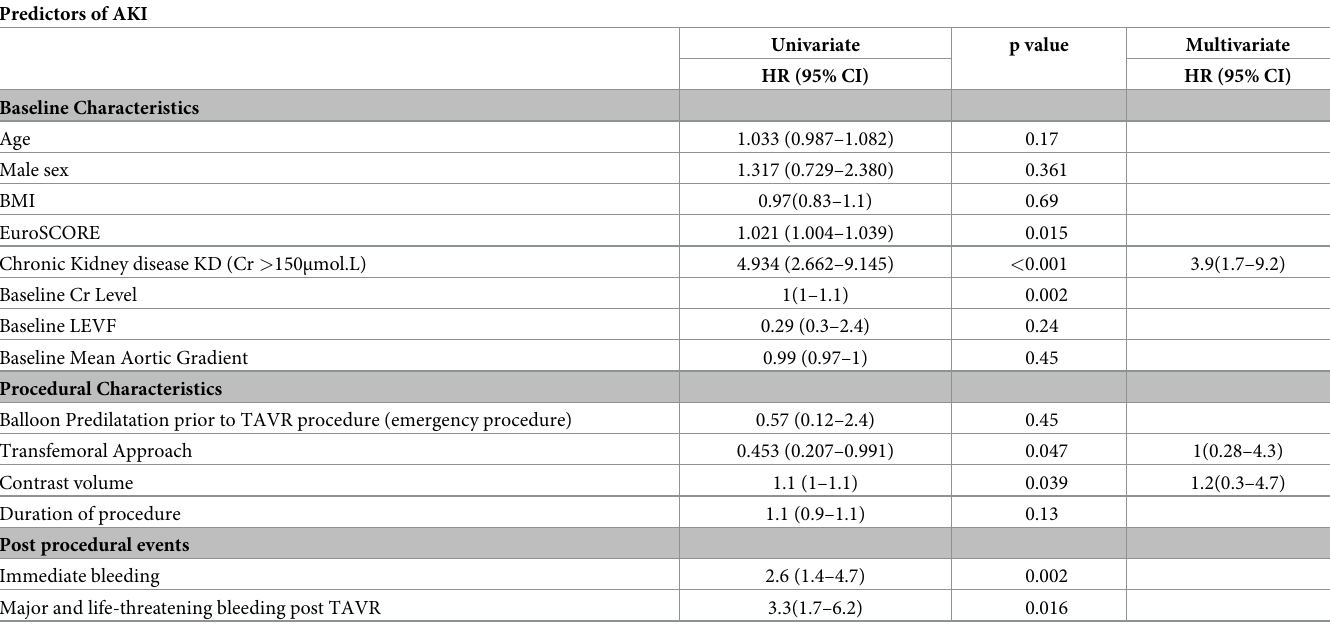
Table 5. Predictors of AKI after